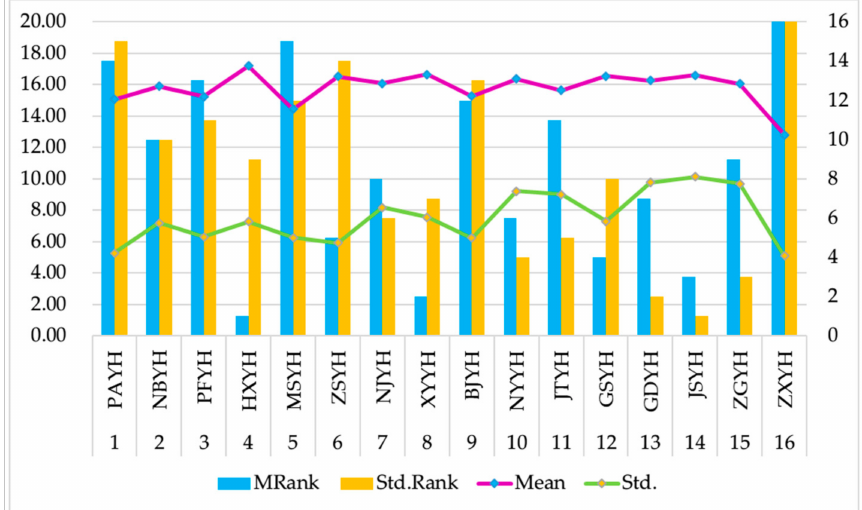
Figure 11. The overall results of the mean and standard deviations of ∆ CoVaR (In the figure, we calculate the daily ∆ CoVaR (the di ff erence between the Conditional Value at Risk (CoVaRs) when the bank is in distress and in a normal state) of each bank, and then derive the corresponding mean and standard deviation for each bank):